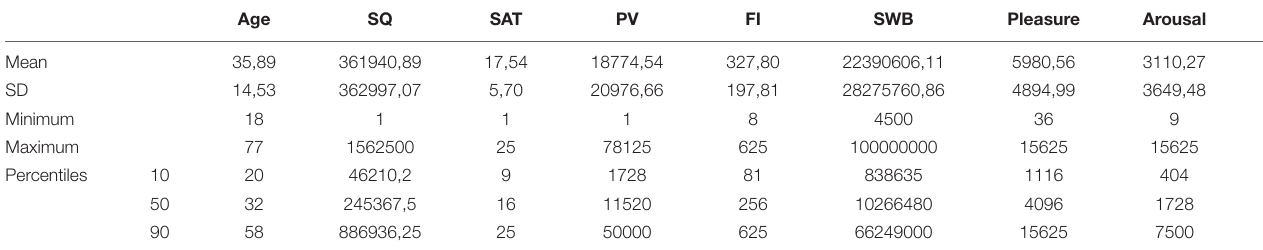
TABLE 2 | Descriptive statistics and calibration values.